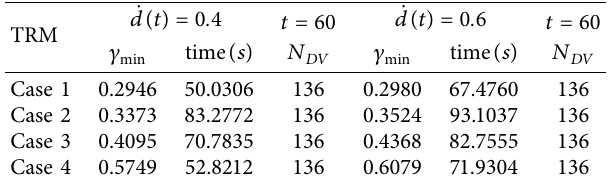
Table 3: Performance comparison results for four different cases of reduced-order FDFs with time-varying